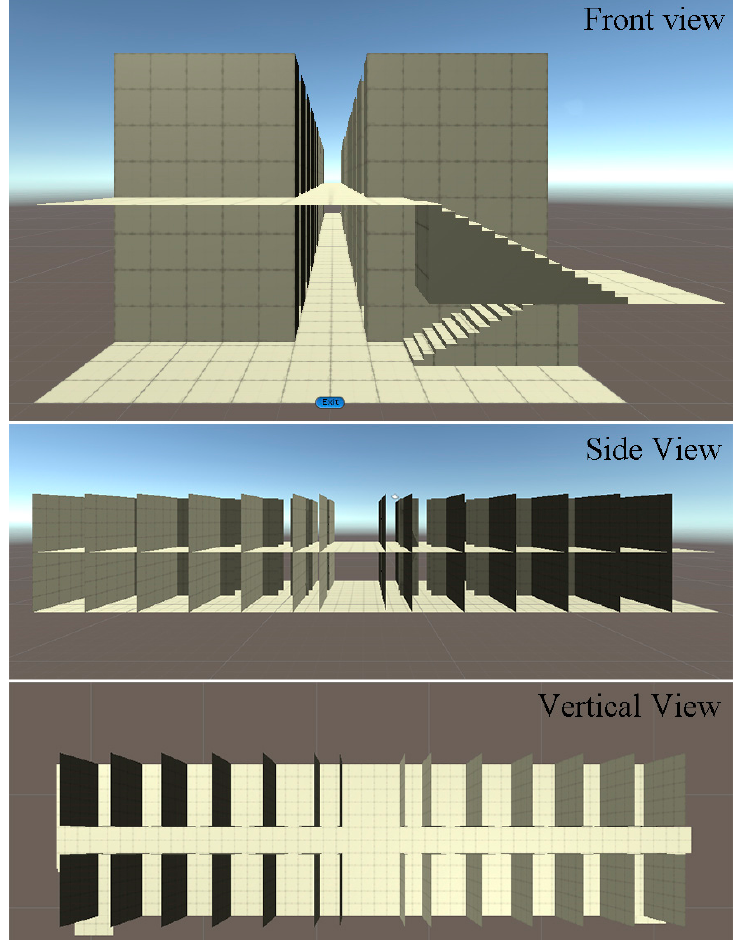
Figure 7. Three views of Yibei dormitory building.